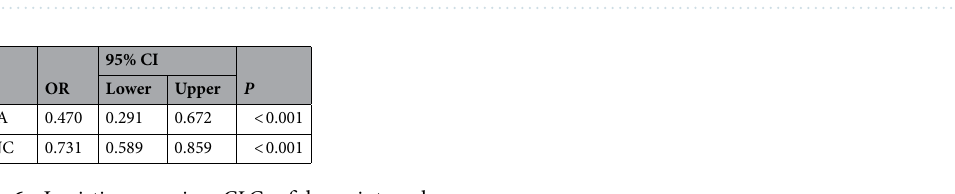
Figure 4. The correlation analysis showed that the DHIA positively correlated with the DHIP ( a ) and SL ( b ). Other correlations were not observed ( c – f ).